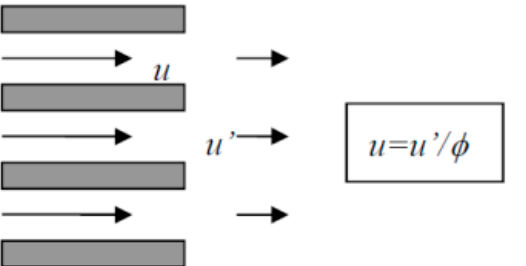
Figure 2. Relationship between the particle velocity inside, u , and outside, u ’, the perforations of an MPP.